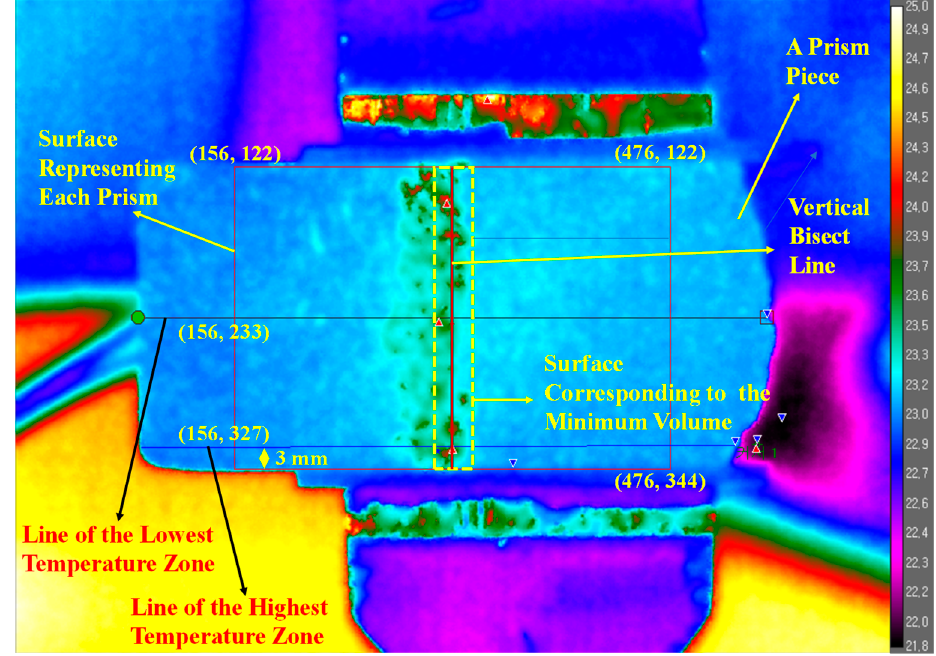
Figure 4. Position of lines and surfaces for measuring temperature increments. The temperature distribution is less than 25°. The prism surface is in the 23° range.